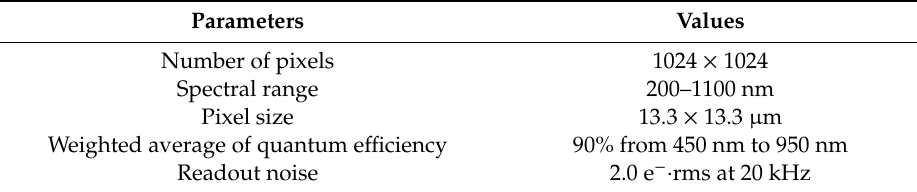
Table 2. Main parameters of